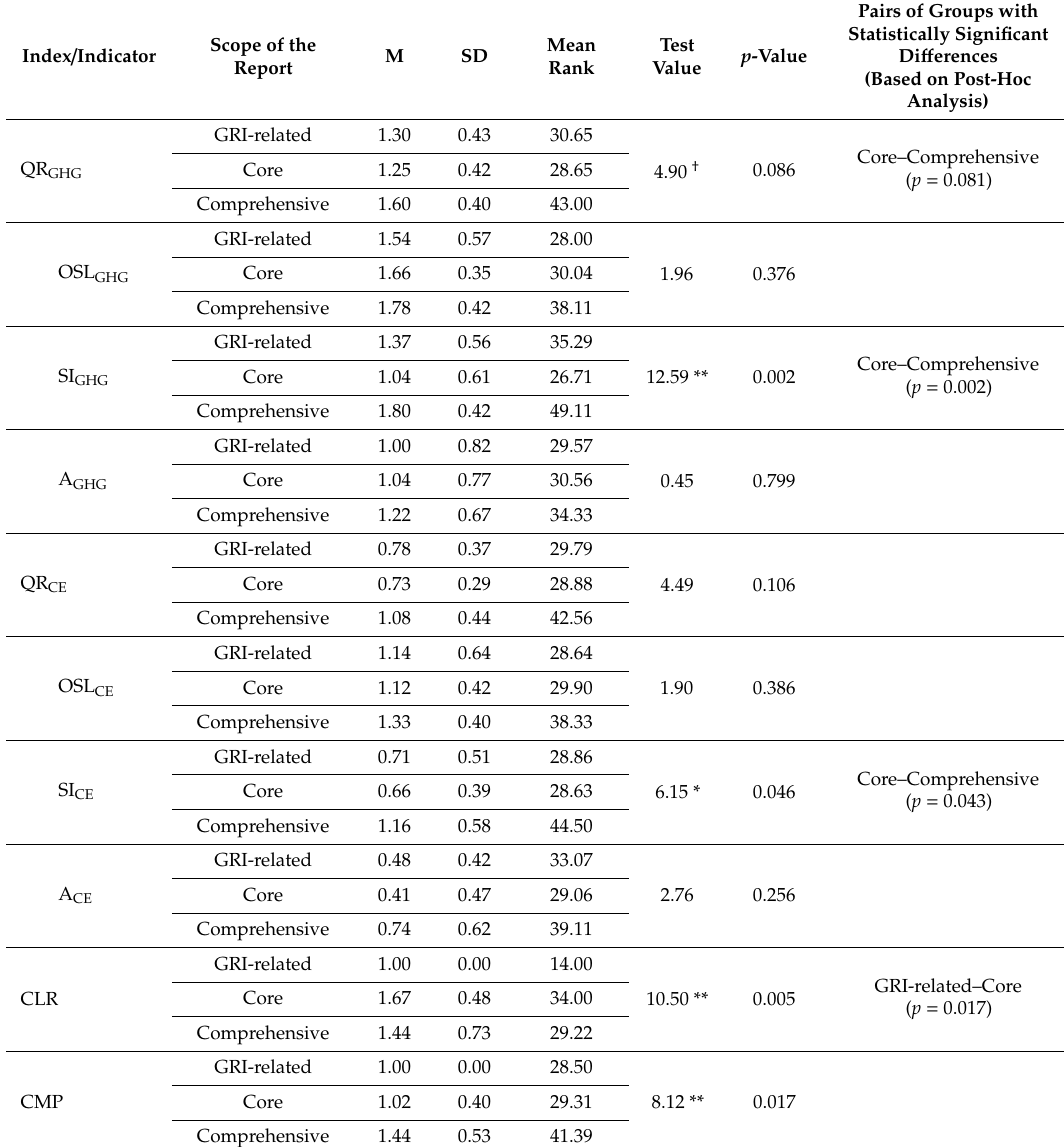
Table 5. Kruskal–Wallis analysis for analyzed indices and indicators among the report option